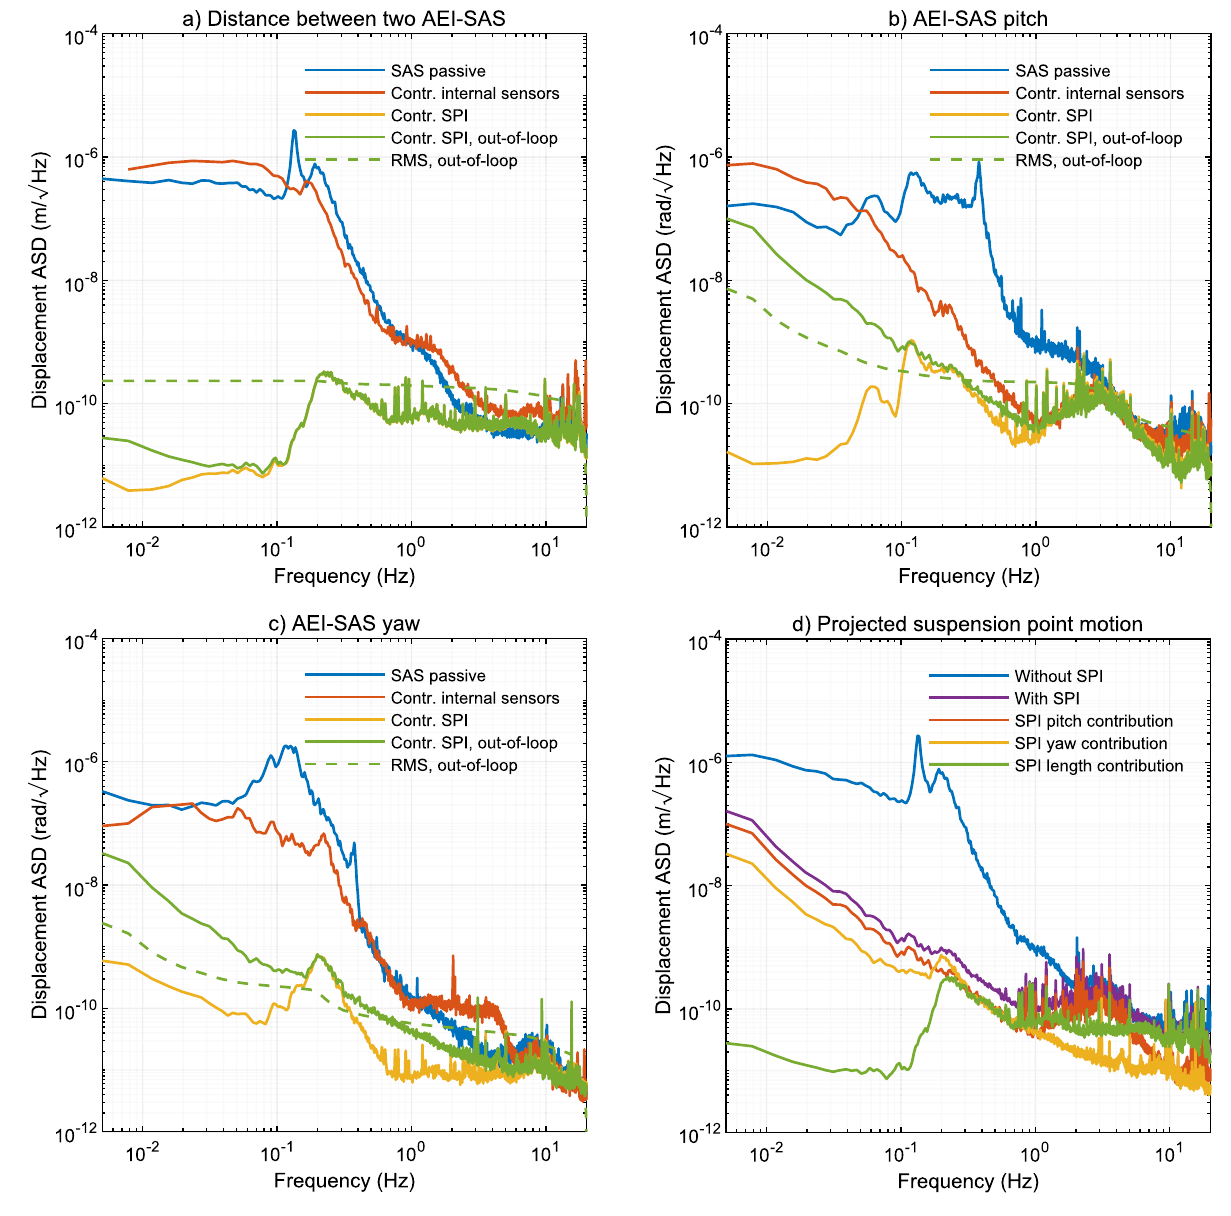
Figure 1. The first three graphics ( a - c ) show the residual Amplitude Spectral Density (ASD) of displacement in length and angle of the AEI-SAS platforms. All data was measured with the sensors of the SPI. Graphic ( a ) shows the residual length fluctuations between two platforms, graphic ( b ) shows the pitch of an individual platform, and graphic ( c ) shows the yaw of one platform. The AEI-SAS can be used without active control, and its passive performance is shown in blue. It is equipped with inertial and relative displacement sensors to the ground. The residual displacement with feedback control with the internal sensors and actuators applied is represented by the red lines. The feedback control with the SPI sensor input is represented by the yellow lines. An additional SPI sensor is used for an independent measurement and is shown in green and the Root-Mean- Square of it is shown in the dashed green curve. ( d ) Shows the projection of the suspension point motion for the suspended optical resonator, in the direction of its optical axis, extrapolated from the seismic platform motion. The blue curve shows the expected suspension point motion without a SPI and the purple curve with a SPI. The red, yellow, and green curves show the effects of pitch, yaw, and length of the seismic isolation platforms on the suspension point